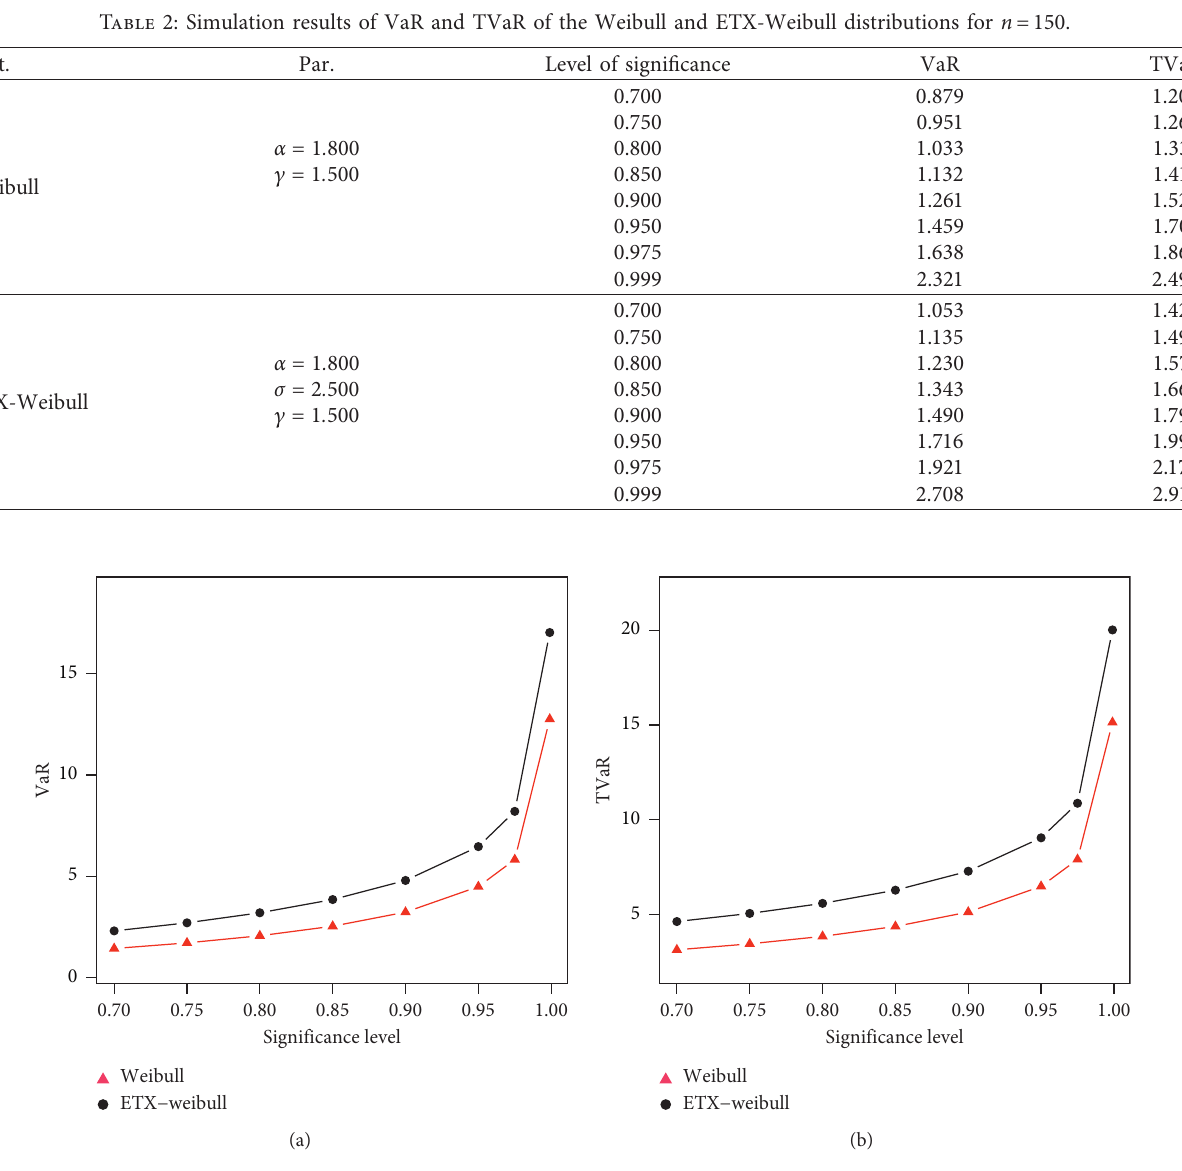
Figure 7: Plots for the VaR and TVaR of the Weibull and ETX-Weibull